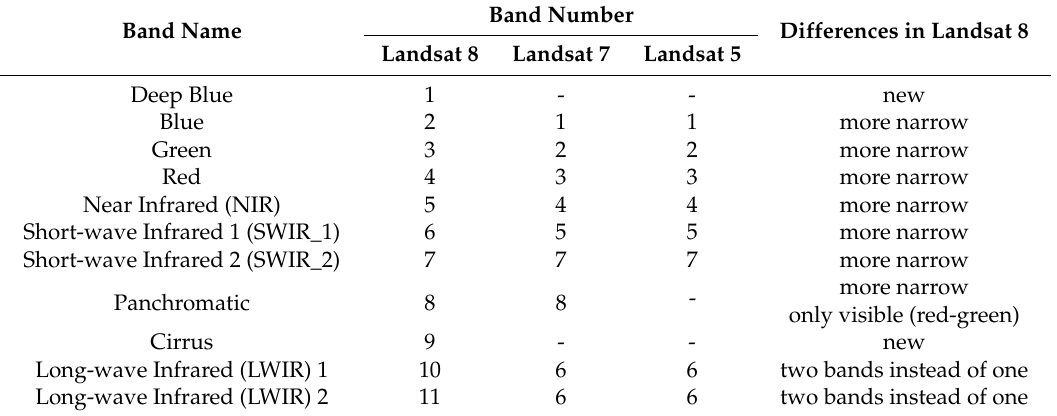
Table 1. Comparing the differences between previous versions of